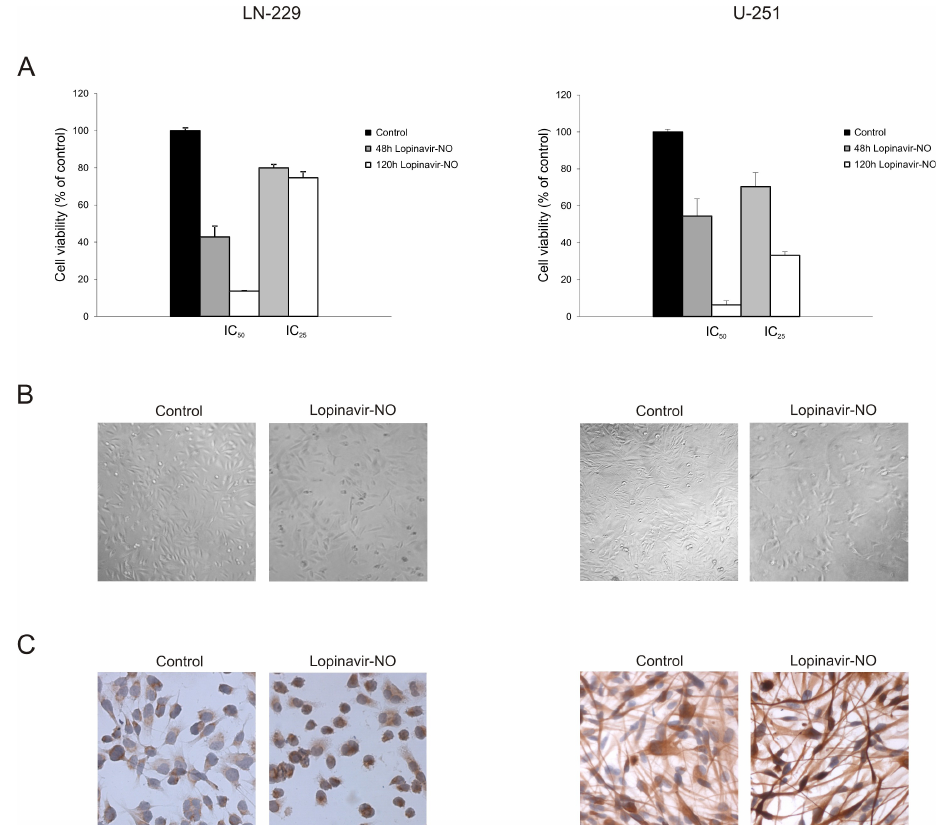
Figure 3. Lopi-NO induced persistent inhibition of proliferation accompanied with phenotype change. GBM cells were treated with IC 50 and IC 25 doses of tested compounds for 48 h, when the drug was removed and ( A ) cellular viability was estimated by CV test after additional 72 h of incubation. ( B ) Cell morphology was assessed by light microscopy after 48 h of incubation in the presence of IC 50 of Lopi-NO (magnification 50 × ). ( C ) Glial fibrillary acidic protein (GFAP) expression in GBM cells after 48 h of incubation in the presence of IC 50 of Lopi-NO (magnification 250 × ). * p < 0.05 in comparison to